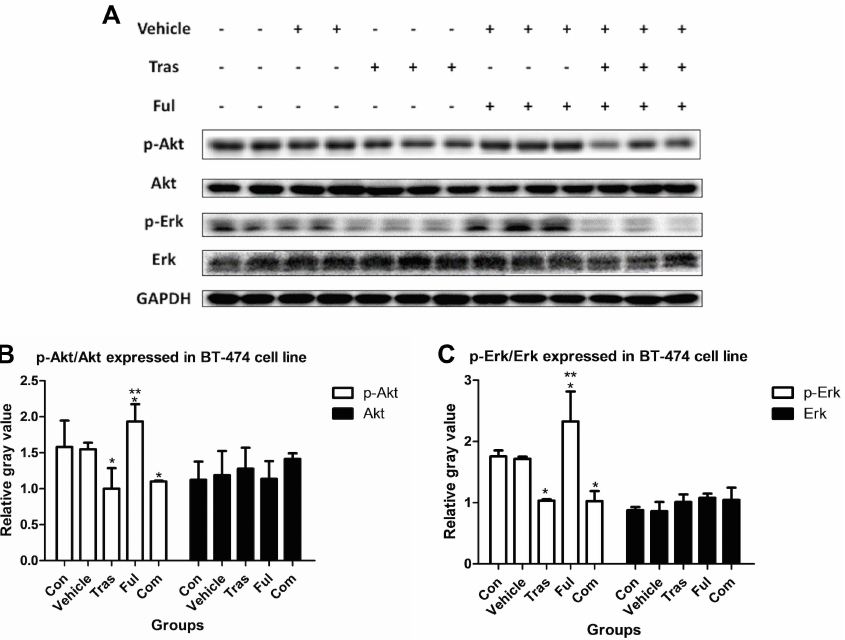
Fig 7. Effects on the levels of the proteins p-Akt and p-Erk extracted from BT-474 cells either untreated or cultured in the presenceof vehicle or trastuzumab at ED 50 or fulvestrant at ED 50 or with a combination of both for 72h. The figure shows that trastuzumab when used as a singleagent decreased the levels of both p-Akt and p-Erk, while fulvestrant raisedthe levels of both proteins. The combination of both drugs significantly preventedfulvestrant from raising the levels of both proteins. * P < 0.05compared with control group. ** P < 0.05compared with combination